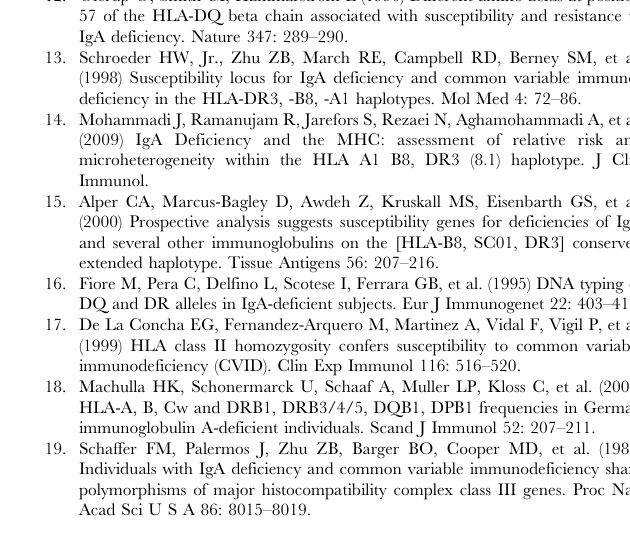
Table S2 Power to detect the association of recombinant haplotypes with IgAD. Power to detect the association of the observed recombinant haplotypes with IgAD in our combined cohort of 772 patients and 1,976 controls. Power calculations were performed assuming a multiplicative model and a disease